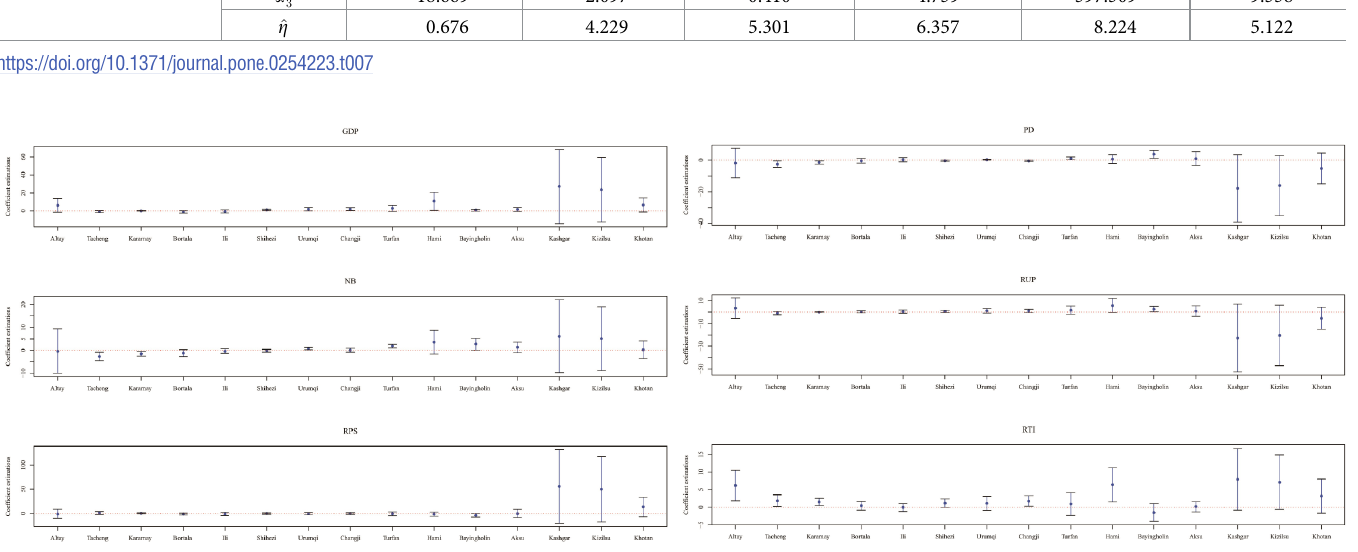
Fig 9. The mean values and 95% confidence intervals of coefficient